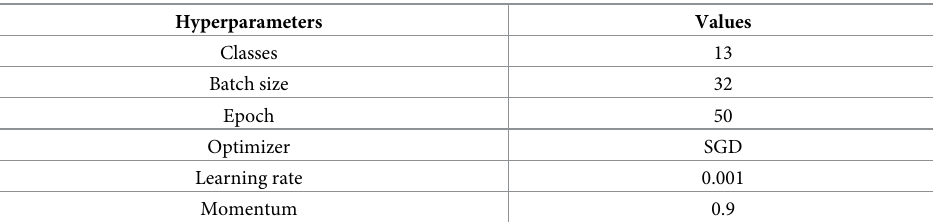
Table 1. Hyperparameter